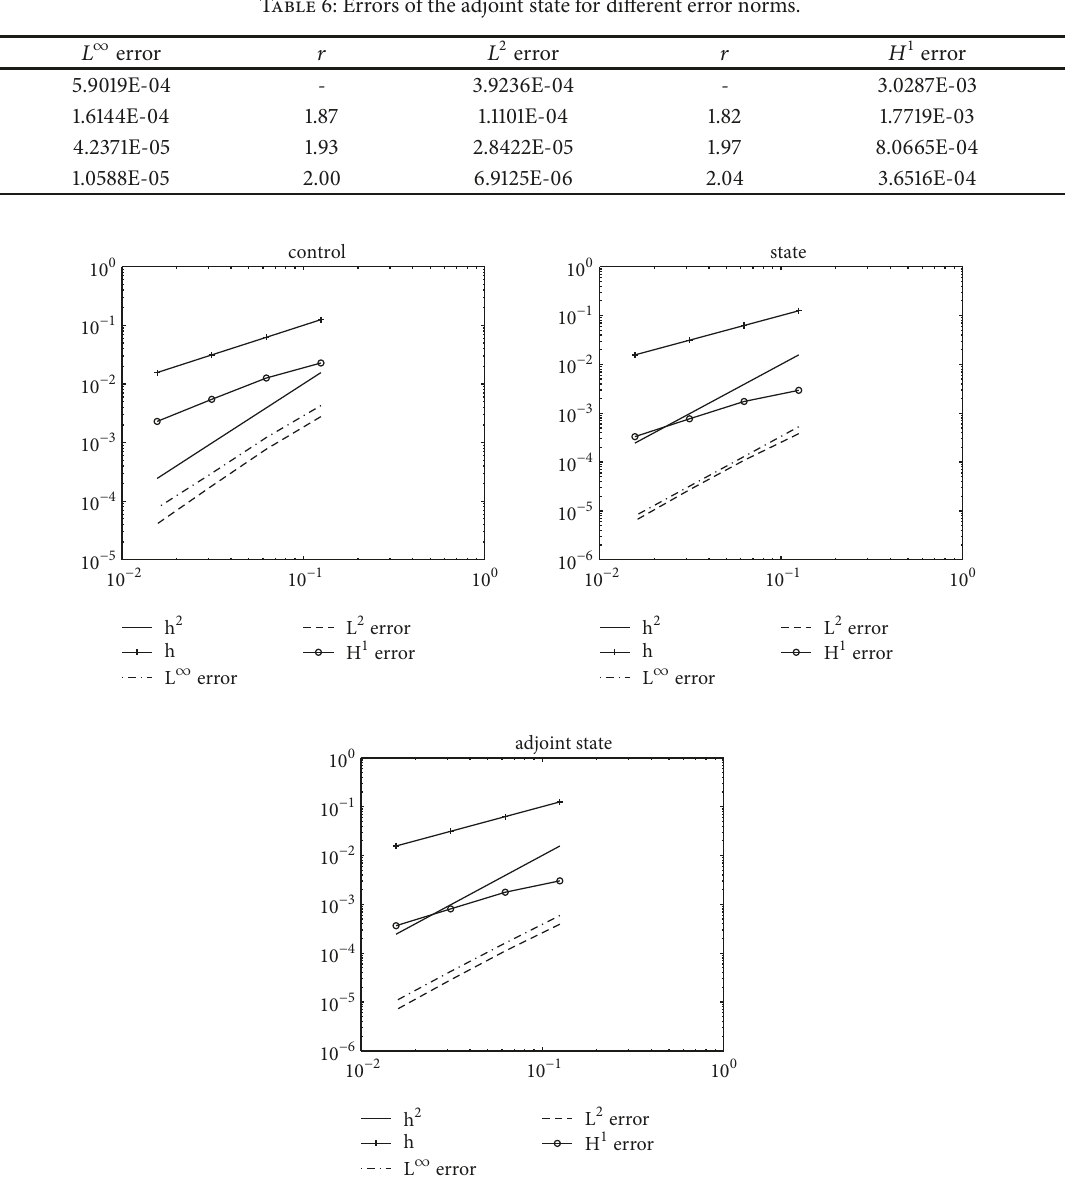
Figure 4: The 𝐿 ∞ , 𝐿 2 , and 𝐻 1 error for the control, state, and adjoint state under uniform refinement of the